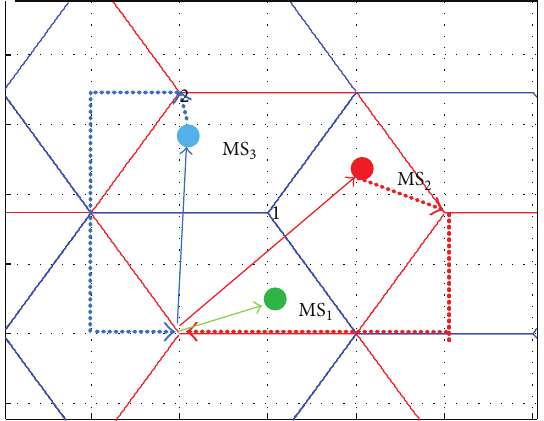
Figure 8: Cooperation among adjacent